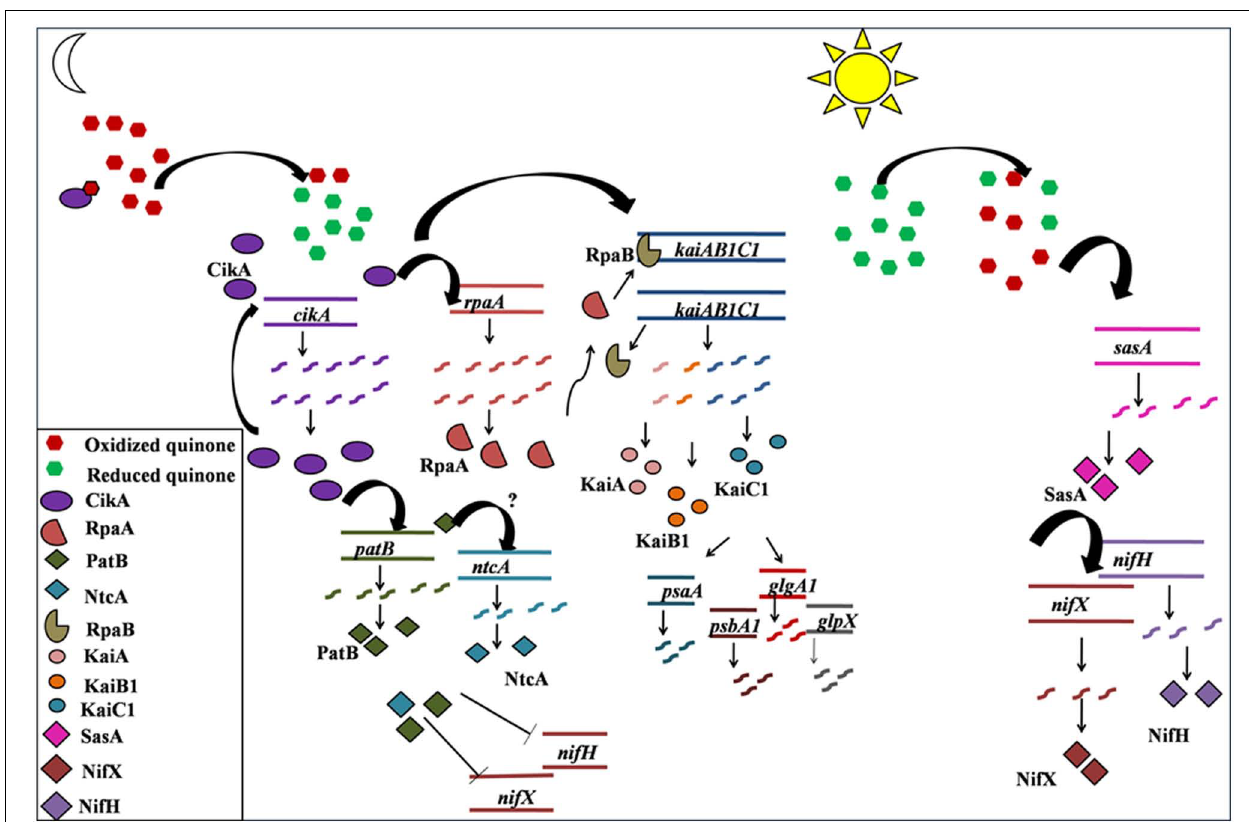
kaiAB1C1 cluster, possibly via RpaA as reported for Synechococcus 7942 (Hanaoka etal., 2012) or by an alternate pathway.The transcription and translation of kaiAB1C1 cluster in turn leads to initiation of transcription of genes for photosystem I and II as well as for glycogen synthesis, all of which peak at dawn in anticipation of the ensuing light phase. Oxidation of PQ pool possibly activates transcription of sasA. SasA activates the transcrition of nif genes which peak at dusk and prepare the system for carrying out nitrogen fixation during the respiratory